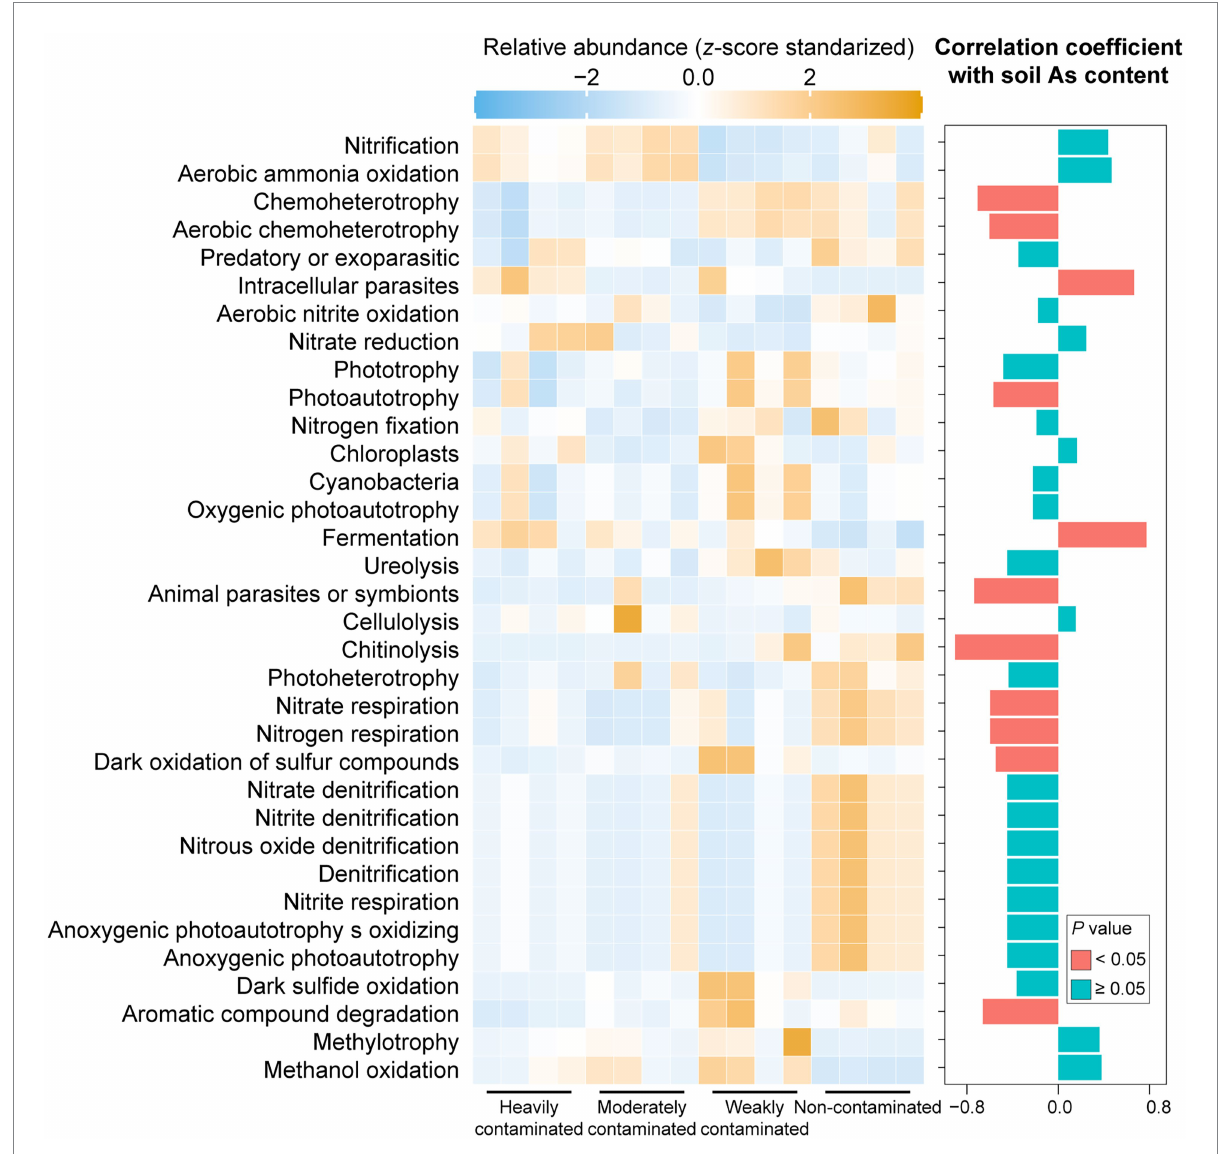
FIGURE 4 Relative abundance of predicted bacterial functions based on the FAPROTAX database in rhizosphere soil of Pteris vittata with different levels of arsenic contamination in the field. Colors in the heatmap represent the relative abundance of predicted bacterial functions in P . vittata rhizosphere soil with different arsenic contamination levels in the field. The bar plot on the right shows the correlation coefficients between predicted bacterial functions and soil arsenic content. The colors of the bars indicate the significance of the correlations between predicted functions and soil arsenic